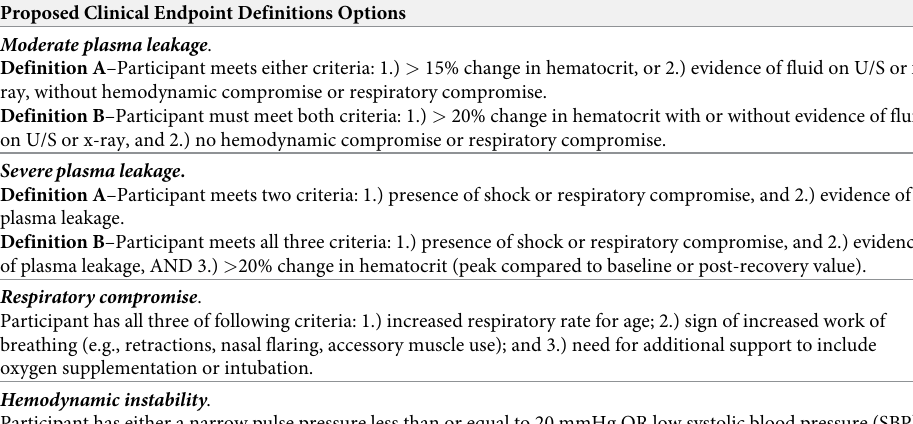
Table 1. Proposed clinical endpoint